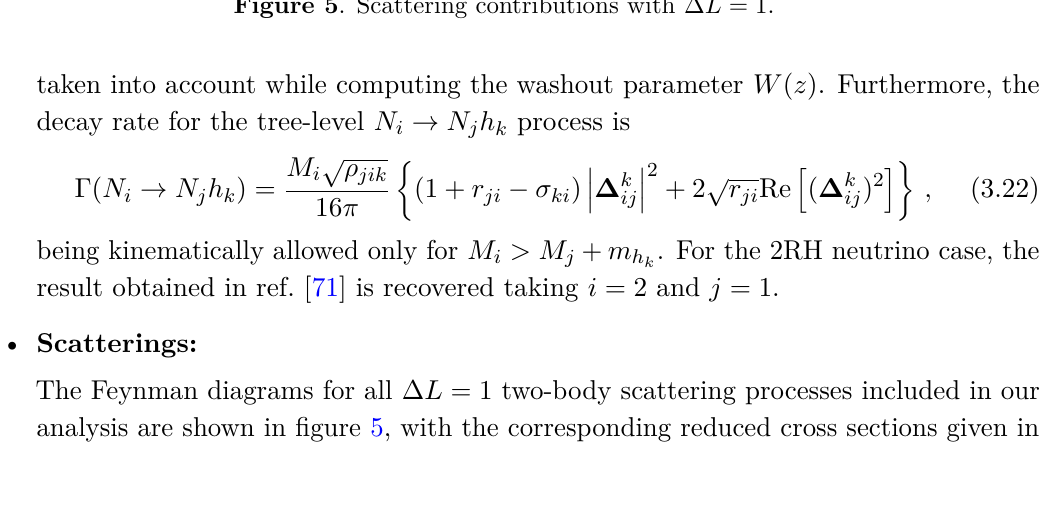
Figure 5 . Scattering contributions with ∆ L = 1